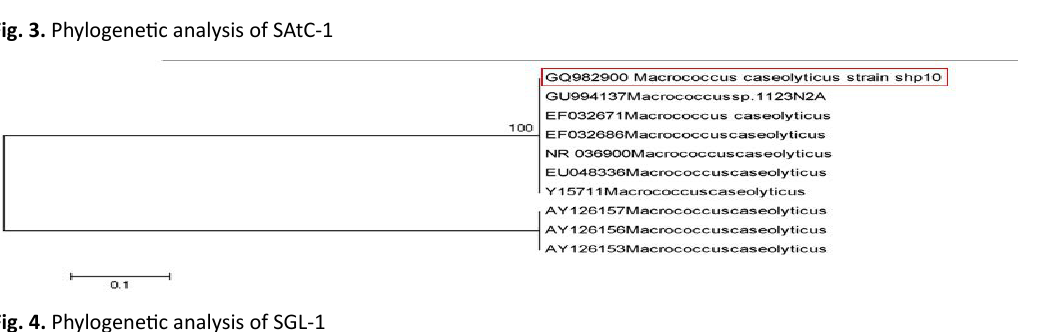
Fig. 4. Phylogenetic analysis of